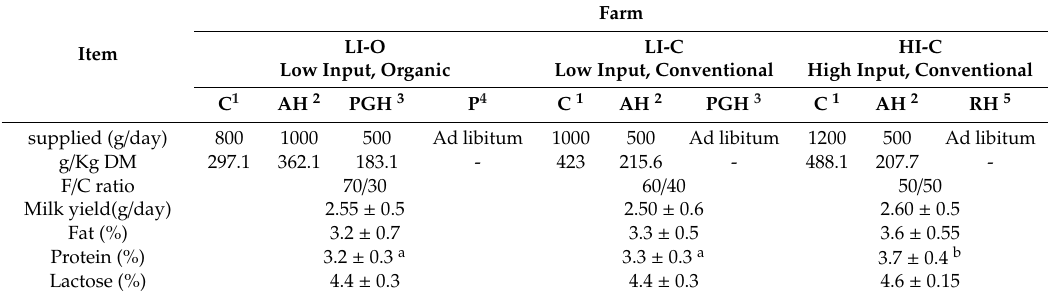
Table 1. Feed intake and milk yield (per goat per day) and composition in LI-O, LI-C, HI-C. Milk composition data are presented as mean ± standard deviation for each